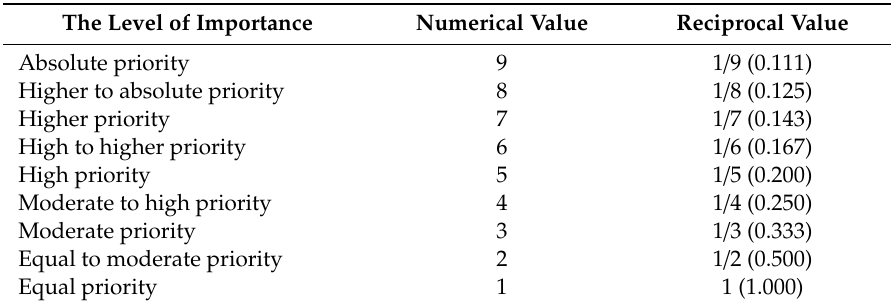
Table 2. AHP scale of importance.